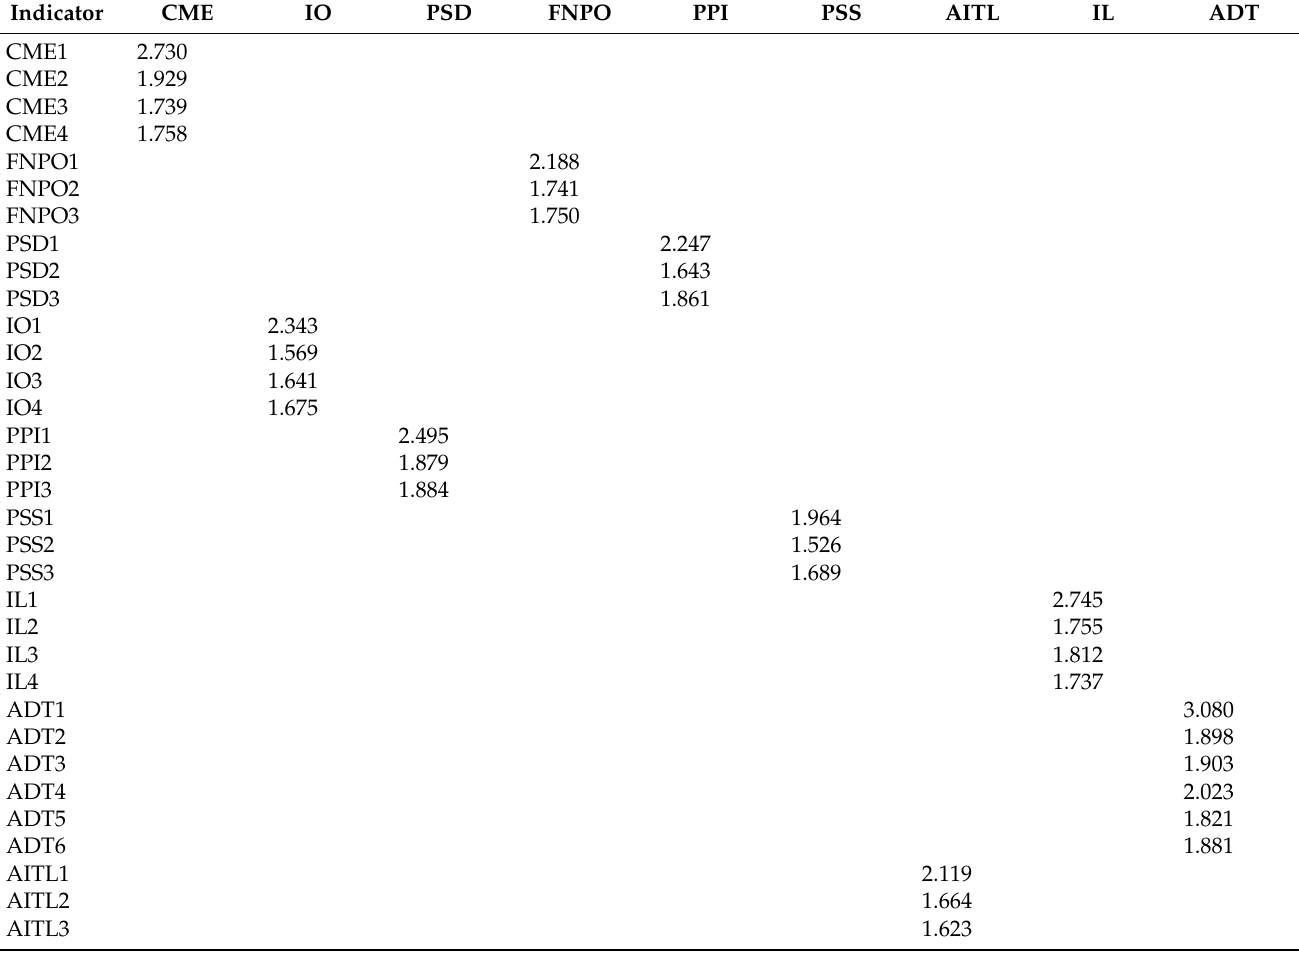
Table A3. Variance Inflation Factors analysis.